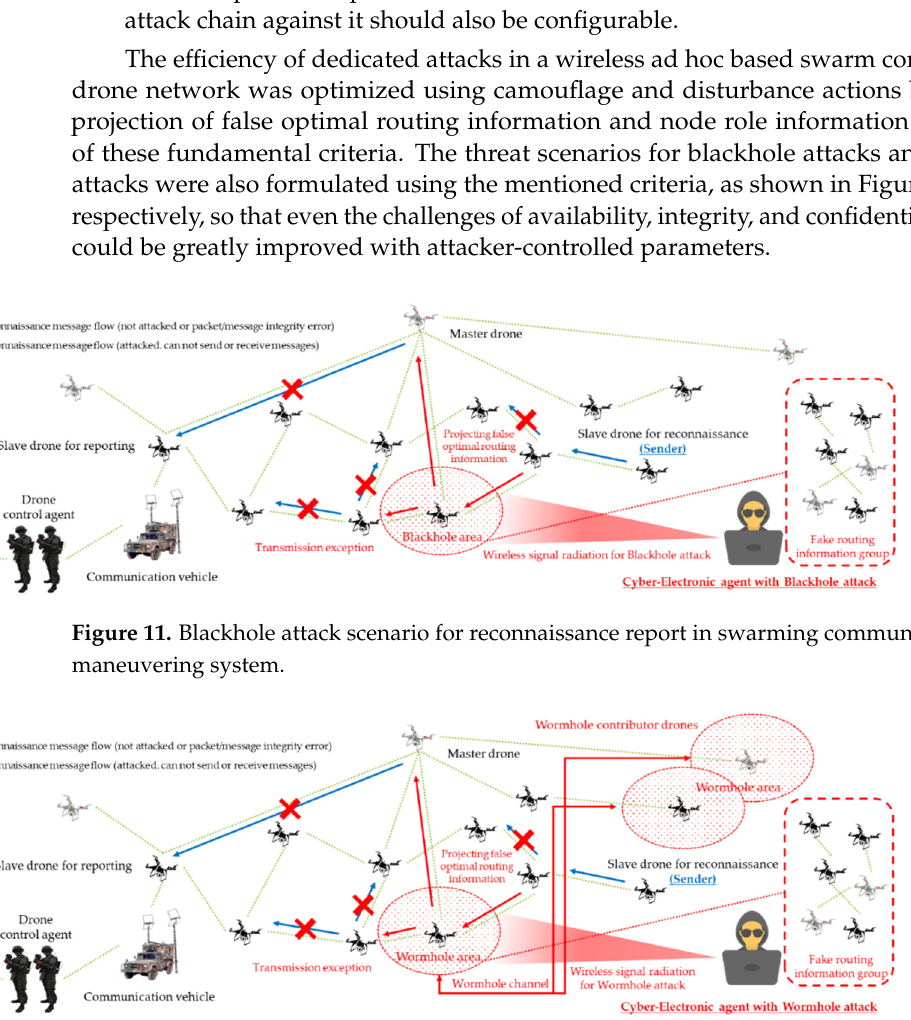
Figure 12. Wormhole attack scenario for reconnaissance report in a swarming communication drones maneuvering system.